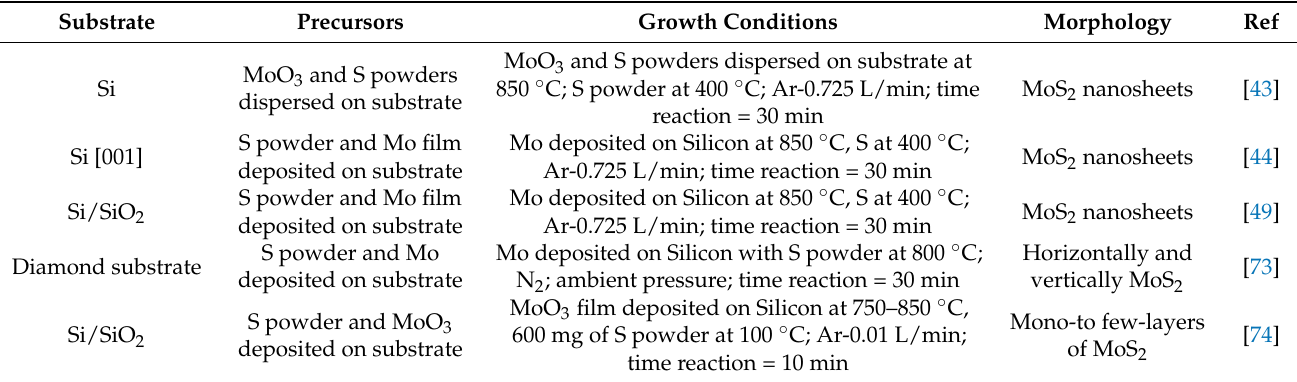
Table 2. Examples of CVD-TVS grown MoS 2 nanostructures.